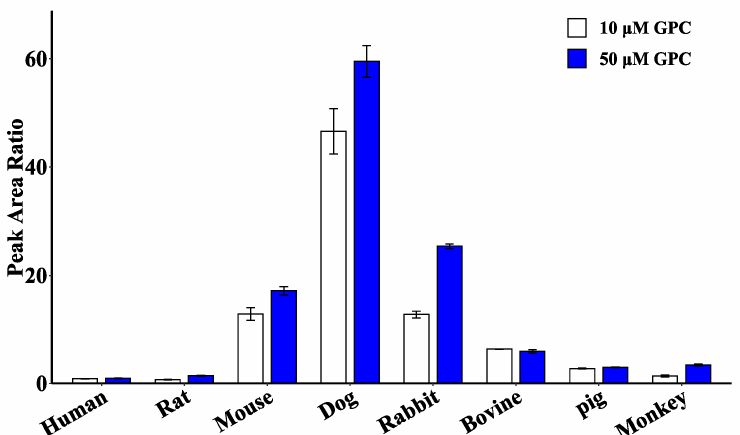
Figure 7. Comparison of glucuronidation metabolite production by 10 and 50 μ M GPC in liver microsomes of different species.